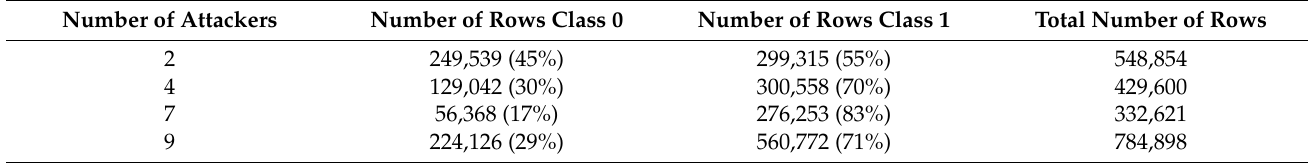
Table 3. The number of rows and class distributions on each